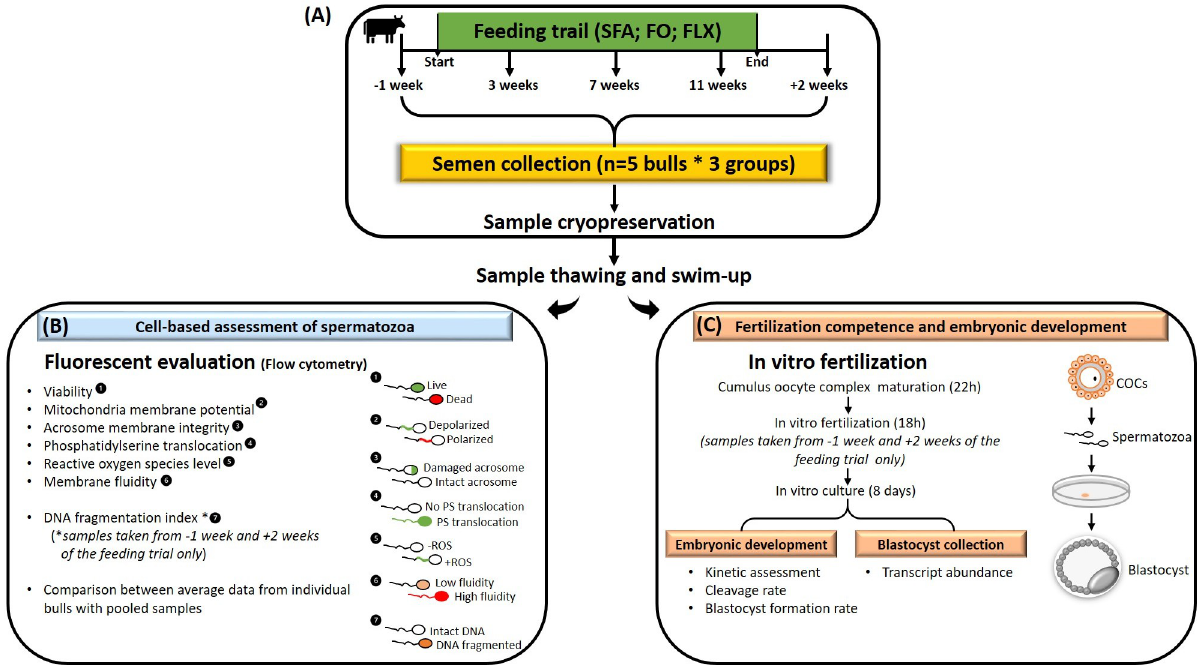
Fig 1. A schematic illustration of the experimental design. (A) Bulls (n = 15) were fed for 13 weeks (feeding period) with saturated fatty acid (SFA; control) or fish oil (FO) or flaxseed oil (FLX), as previously described by our group [8]. Semen was collected before (-1 week), during (3, 7, and 11 weeks) and after (+2 weeks) the feeding period. Collected semen was frozen in straws and stored in liquid nitrogen until further analysis. Samples were thawed, subjected to the swim-up procedure, and then evaluated for cell-based assessment of spermatozoa (B) and fertilization competence and embryonic development (C). (B) Cell-based assessment of spermatozoa (n = 25,000 spermatozoa/group) was evaluated by flow cytometry and included plasma membrane integrity, mitochondrial membrane potential, acrosomal membrane integrity, phosphatidylserine translocation, reactive oxygen species (ROS) level, membrane fluidity and DNA fragmentation index. (C) Fertilization competence and embryonic development were examined by in-vitro production of embryos. Cumulus oocyte complexes (COCs) were divided into three groups and in-vitro matured for 22 h, then fertilized with pooled SFA, FO, or FLX samples collected before the feeding period (-1 week; 3 replicates) and after the feeding period (+2 weeks; 3 replicates). Fertilization competence was recorded as the proportion of oocytes that cleaved to 2- to 4-cell-stage embryos 42–44 h post fertilization and the proportion of embryos that developed to the blastocyst stage on day 8 post fertilization. The embryos’ developmental kinetics was recorded in a time- lapse incubator, including the timing of the 1 st , 2 nd , and 3 rd division, and blastocyst formation (i.e., the formation of a blastocoel cavity within the embryo). Twelve blastocysts were individually collected from each experimental group and subjected to mRNA extraction, followed by qRT-PCR, to examine the long-lasting effects of treatment from the spermatozoa to the developed embryo (i.e., the paternal effect). Fig 1 was created by Dr. Kalo with Microsoft PowerPoint